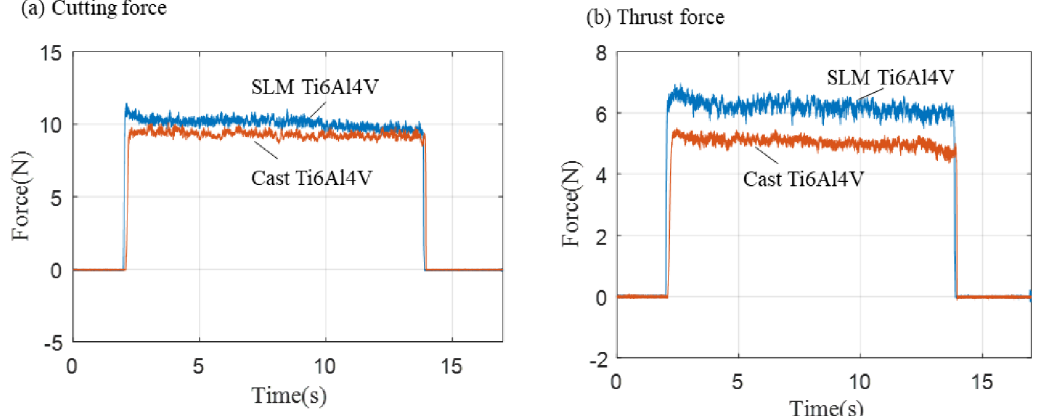
Figure 5. Comparison of the dynamic cutting force curve between SLM Ti6Al4V and cast Ti6Al4V, the depth of cut was 20 µ m, and the cutting speed was 60 mm/s. ( a ) cutting force; ( b ) thrust force.